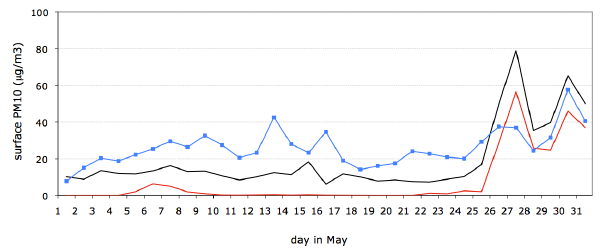
Fig. 4. Observed surface PM 10 (blue), and simulated daily averages Figure 4. Observed surface PM10 (blue), and simulated daily averages of total aerosol mass (black) and dust mass (red) ( µ g/m 3 ) . of total aerosol mass (black) and dust mass (red) (µg/m 3